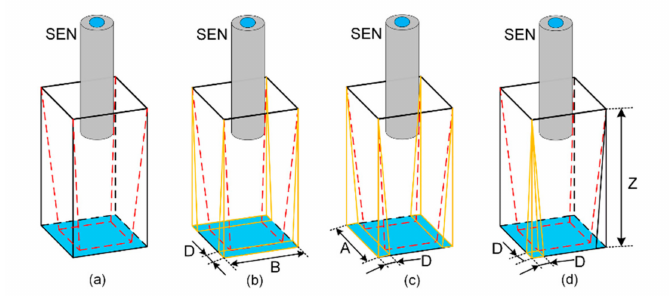
Figure A1. The sketch diagram of solving volume flux converted into the solidified shell: ( a ) total volume converted into the solidified shell at a cross section; ( b ) volume components at front and back; ( c ) volume components at left and right; and ( d ) surplus volume components at one corner.